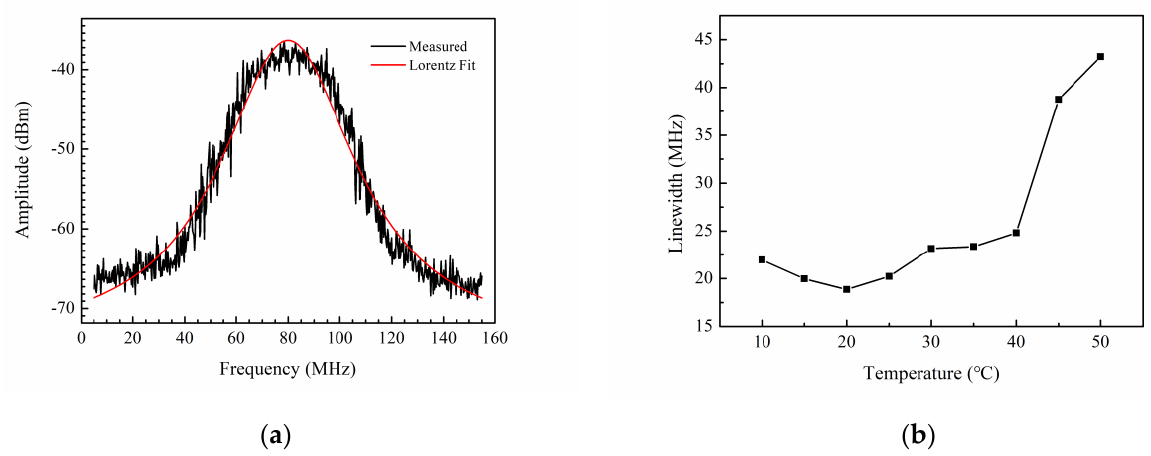
Figure 7. ( a ) 3 dB linewidth measurement result at 20 °C; ( b ) 3 dB linewidth measurement results at different temperatures.